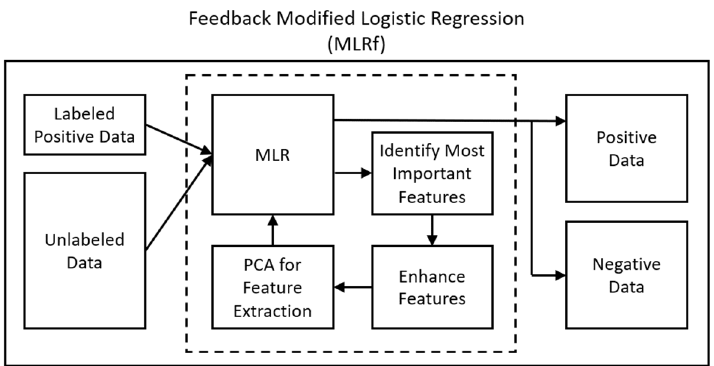
Figure 1. The proposed feedback-enhanced modified logistic regression (MLRf). The proposed MLRf algorithm consists of the following five